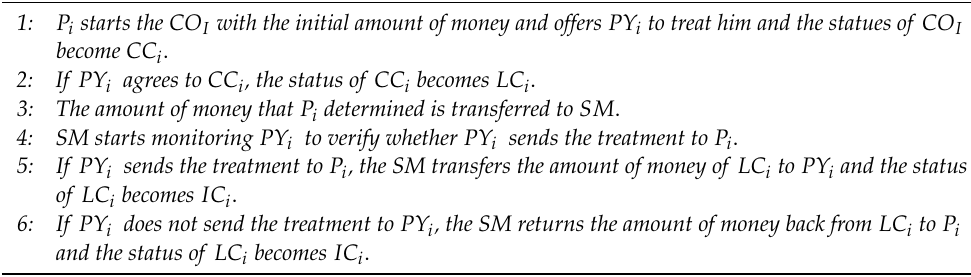
Algorithm 3 . Medical smart contract algorithm